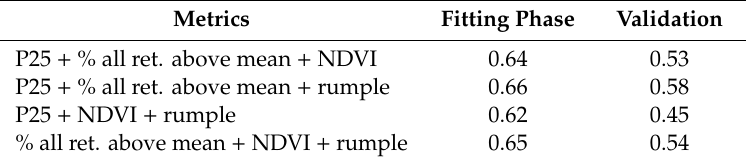
Table A3. Variation in overall accuracy to determine metric importance using SVMr classification